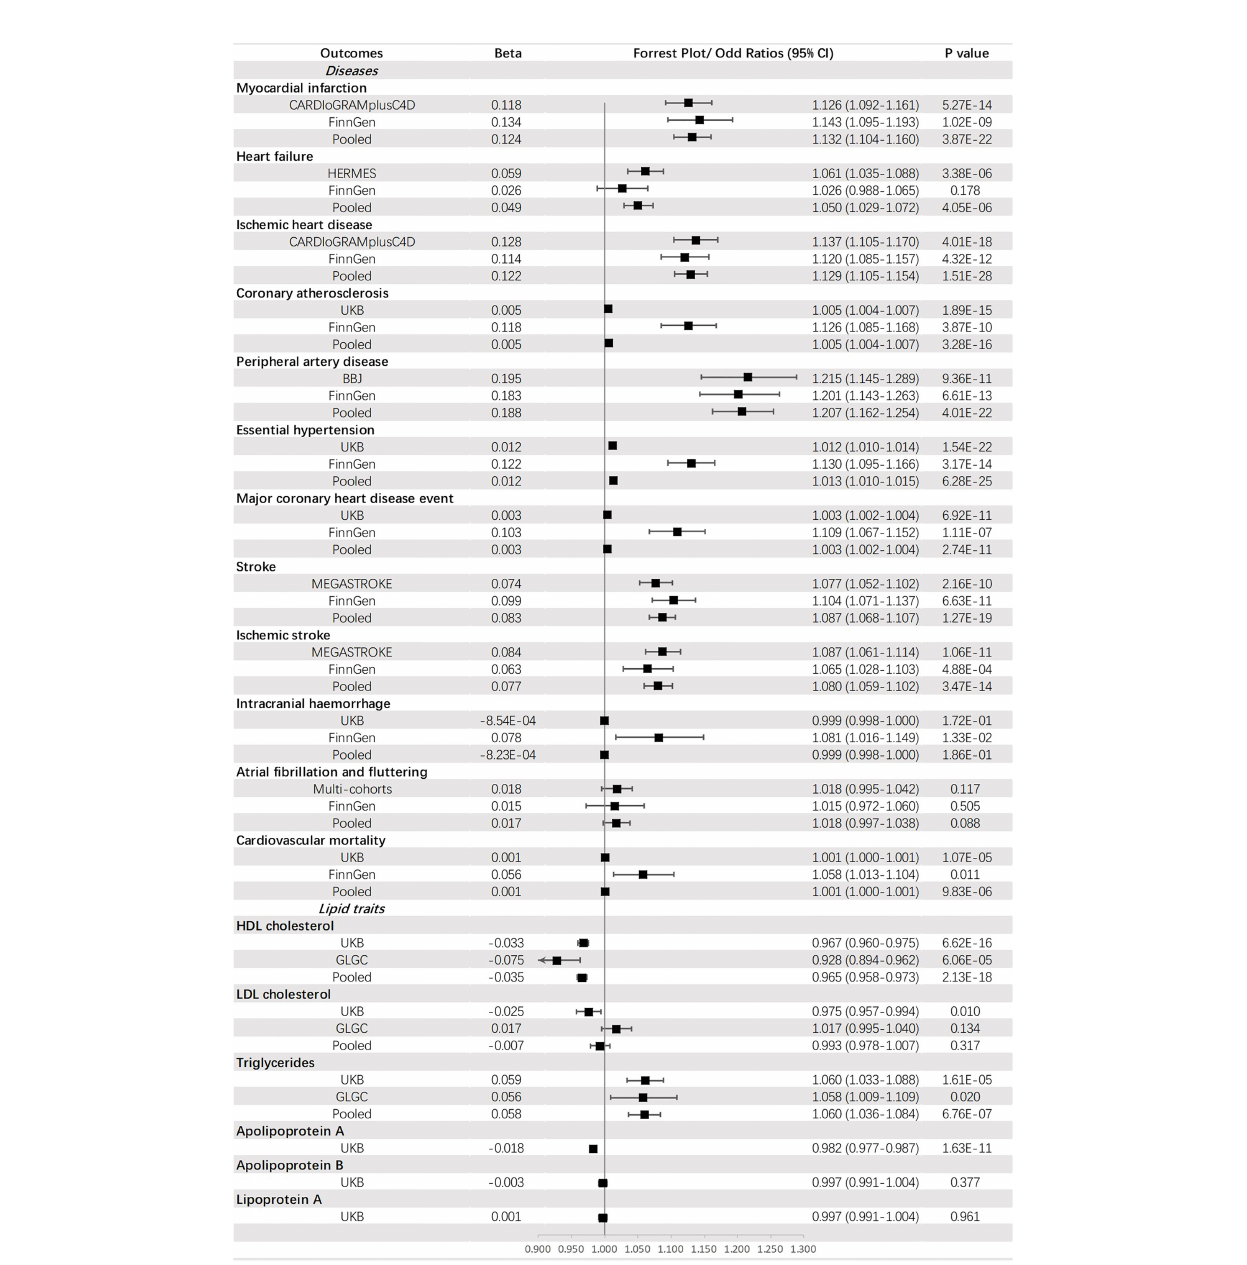
FIGURE 3 | The association between type 2 diabetes mellitus and